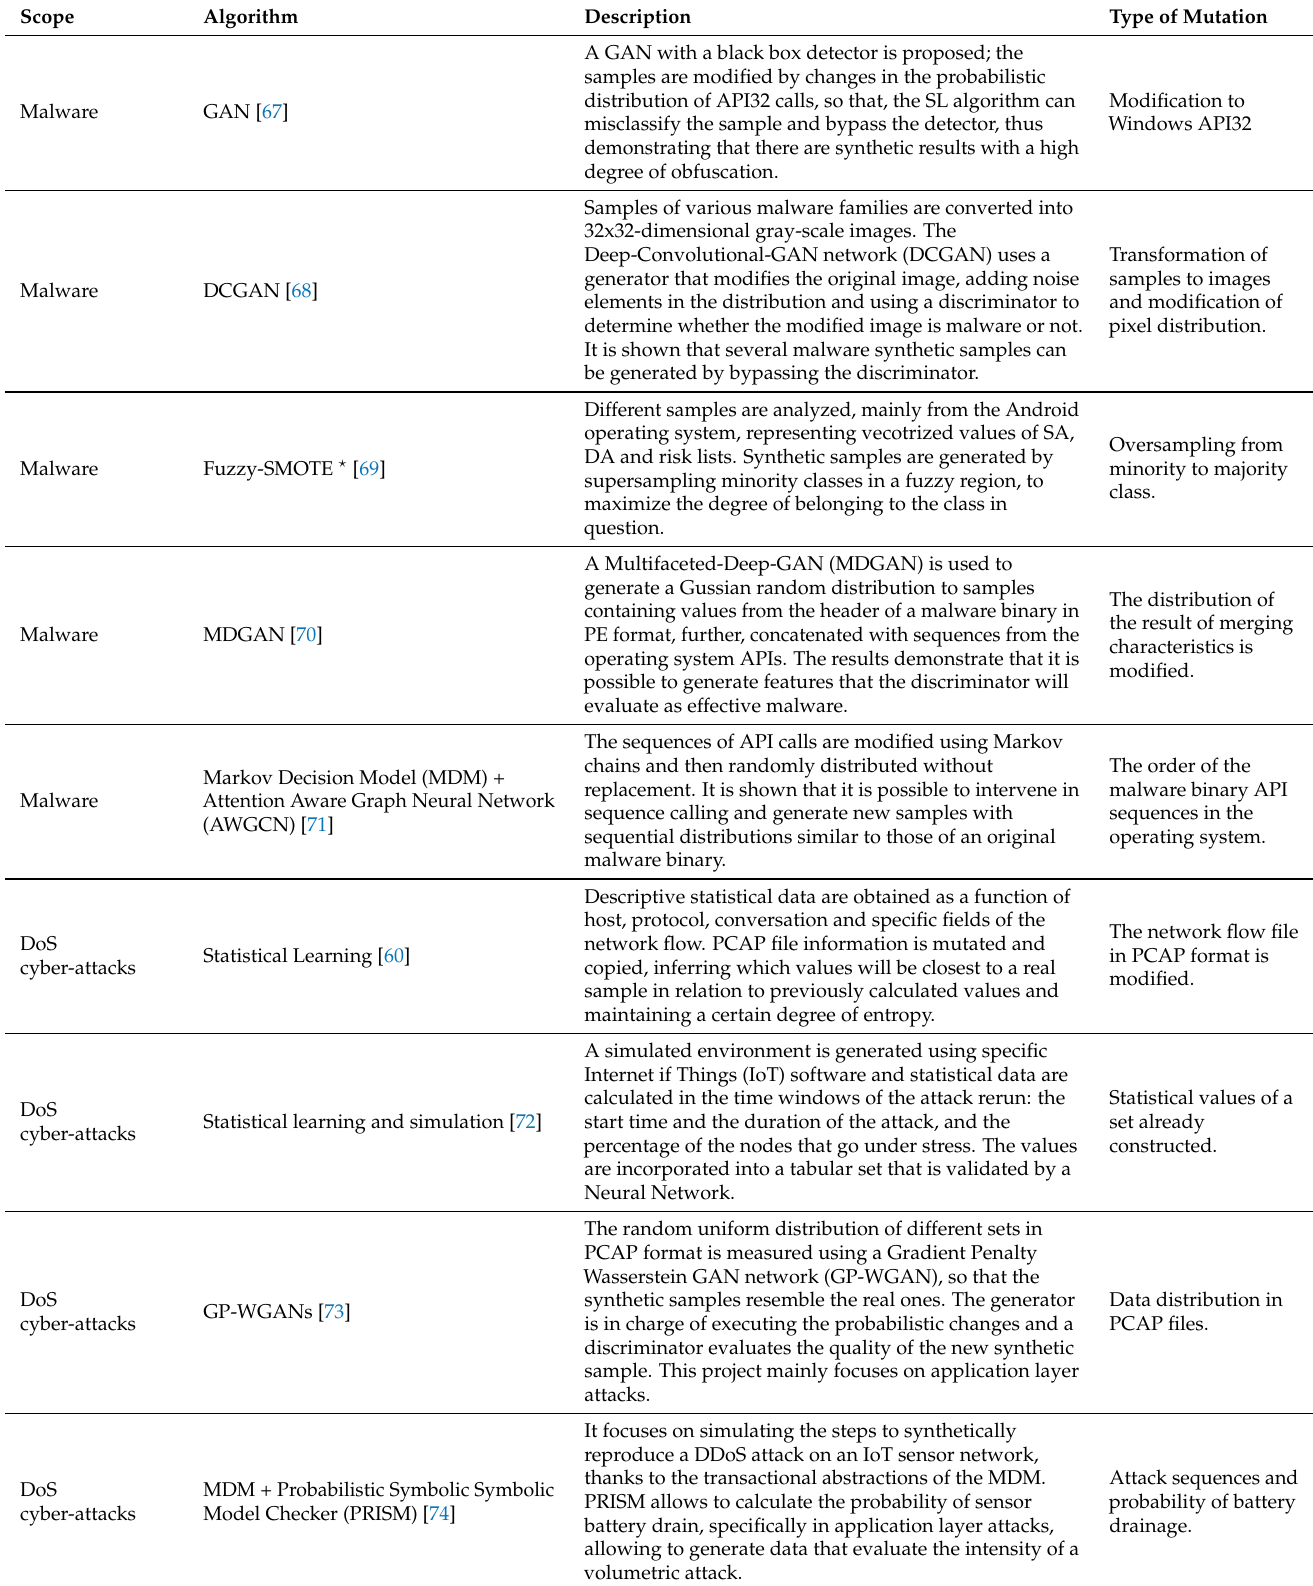
Table 7. Related work on synthetic generation of malware and DoS cyber-attacks